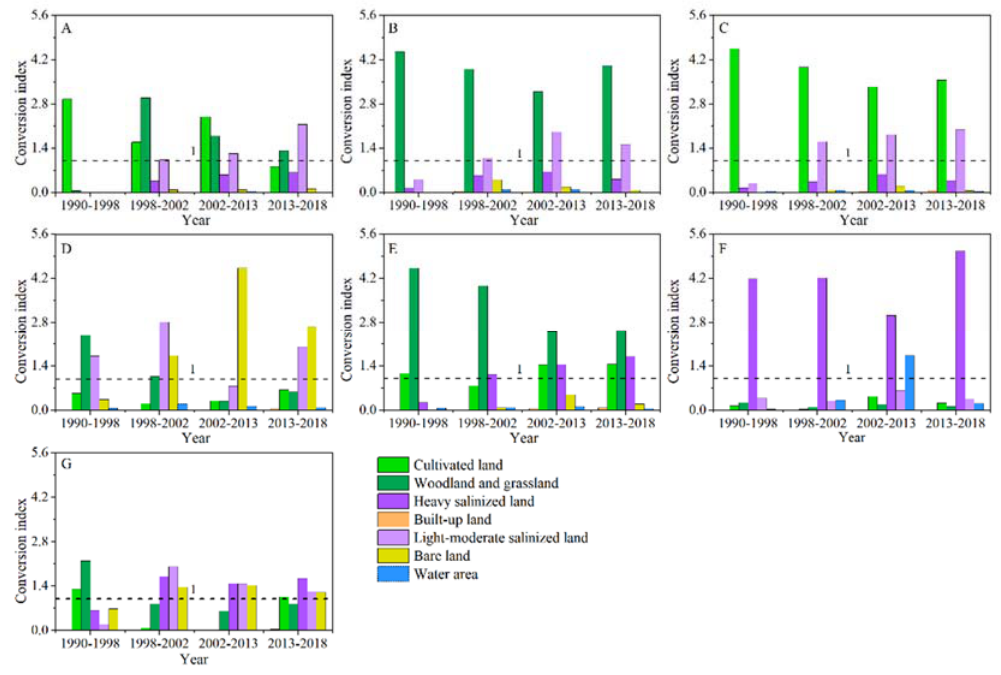
Figure 4. Shift index among di ff erent LULC types in the periods 1990-1998, 1998-2002, 2002-2013 and 2013-2018. ( A – G ) represent the shift indexes of the specific LULC types to BUL, CL, WLGL, HSL, LMSL, BL and WA, respectively.